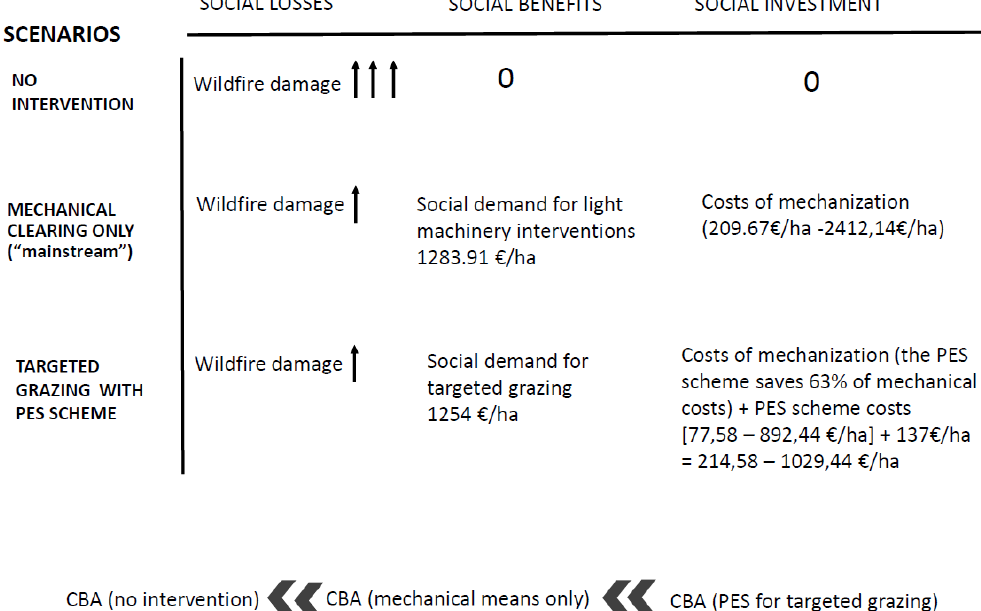
Figure 2. Rough estimate of Extended Costs and Benefit Analysis for three alternative scenarios of fire prevention: no fire prevention, fire prevention with mechanical clearing of biomass, remunerated targeted grazing service. Estimates of social benefits based on Varela et al. [15]. Estimates of social investment in the scenario with a targeted grazing scheme based on public tariffs and [16].